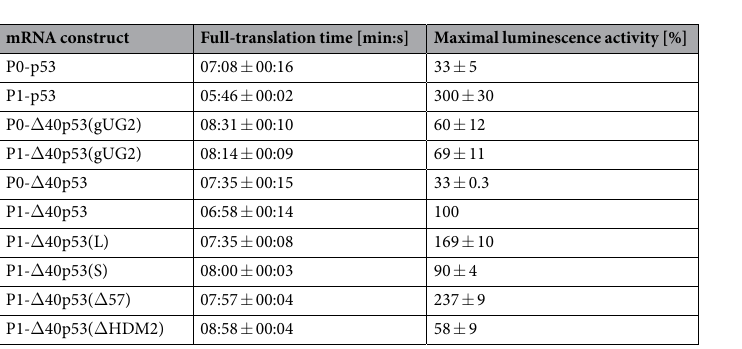
Table 1. Comparison of full-translation time and maximal luminescence activity for each mRNA construct. Full-translation time with standard deviation was calculated for each construct based on three independent experiments. The maximal luminescence activity obtained for each construct was normalized to the value obtained for the P1- Δ 40p53 variant and standard deviations are indicated in the